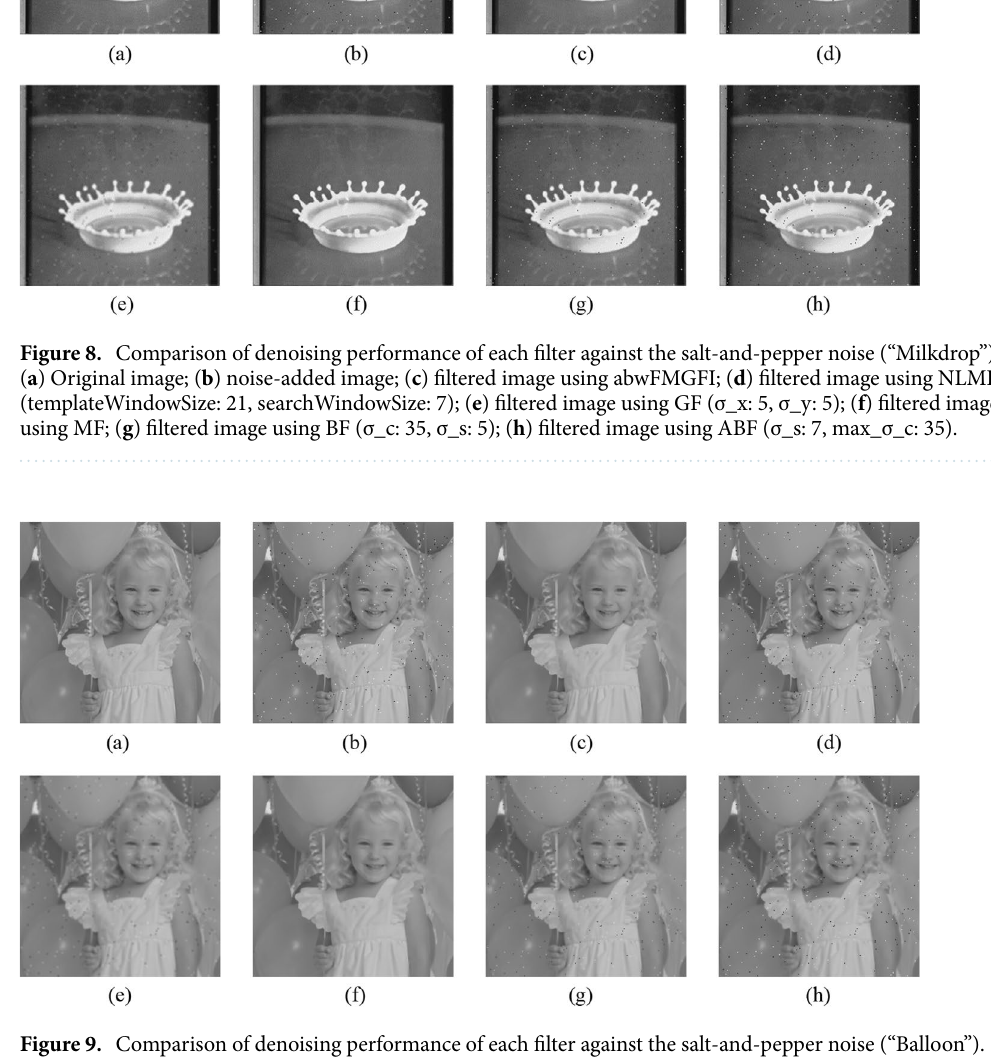
gray. In the visual evaluation, the proposed method and FMGFI (basic width = 3, 5, 11, 21 level) reduced the noise to a comparable level, whereas the rough texture remains because the noise is not entirely removed. The FMGFI (basic width = 51 level) blurs the edges, and the FMGFI (basic width = 1 level) shows little change and could not reduce the noise. As presented in Tables 9 and 10, the FMGFI (basic width = 11, 21, 51 level) tends to have lower RMSE values and higher SSIM values than those of the proposed method. However, it cannot be considered that the FMGFI (basic width = 51 level) is high in the reproduction of the original image because the FMGFI (basic width = 51 level) blurs the edges. From the above, we consider that the denoising performance of the proposed method against the Gaussian noise is the same as that of the FMGFI in visual evaluation. Edge preservation experiment. The edge preservation performance of the proposed method is veri- fied. In this experiment, the edge preservation performances of each filter on the wafer-added sample image is compared based on visual evaluation and using two evaluation parameters. Because edge preservation is easy to achieve in the case of a geometric image, the images filtered using each filter differed very slightly. Therefore, for